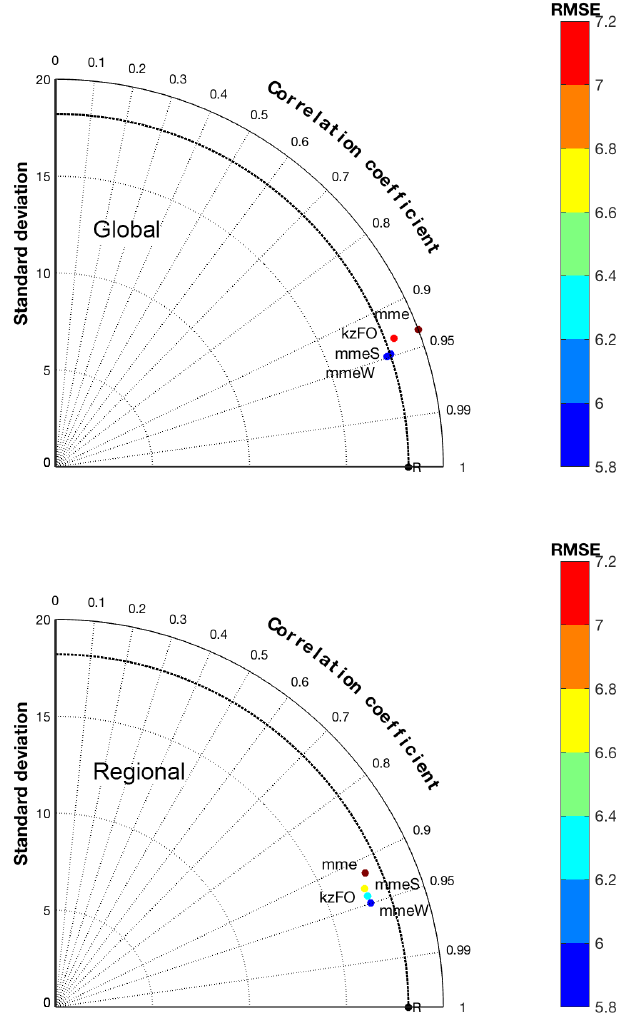
Figure 6. Taylor diagram of the four ensemble treatments consid- ered in the text obtained from the global and regional